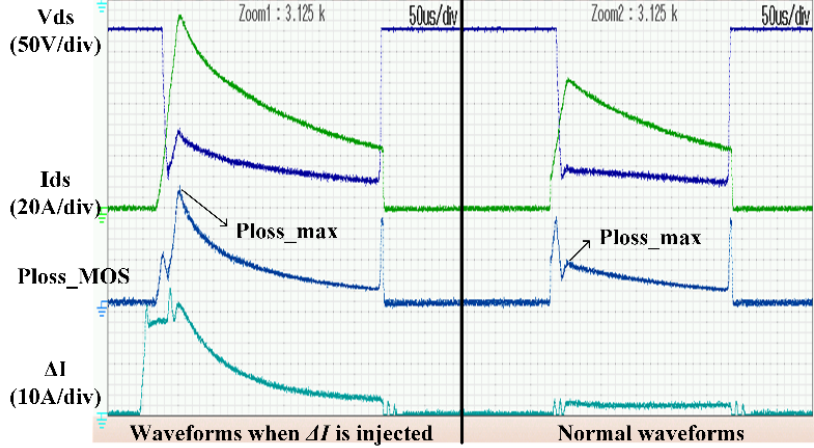
Figure 21. Comparison of conduction loss of MOSFET.